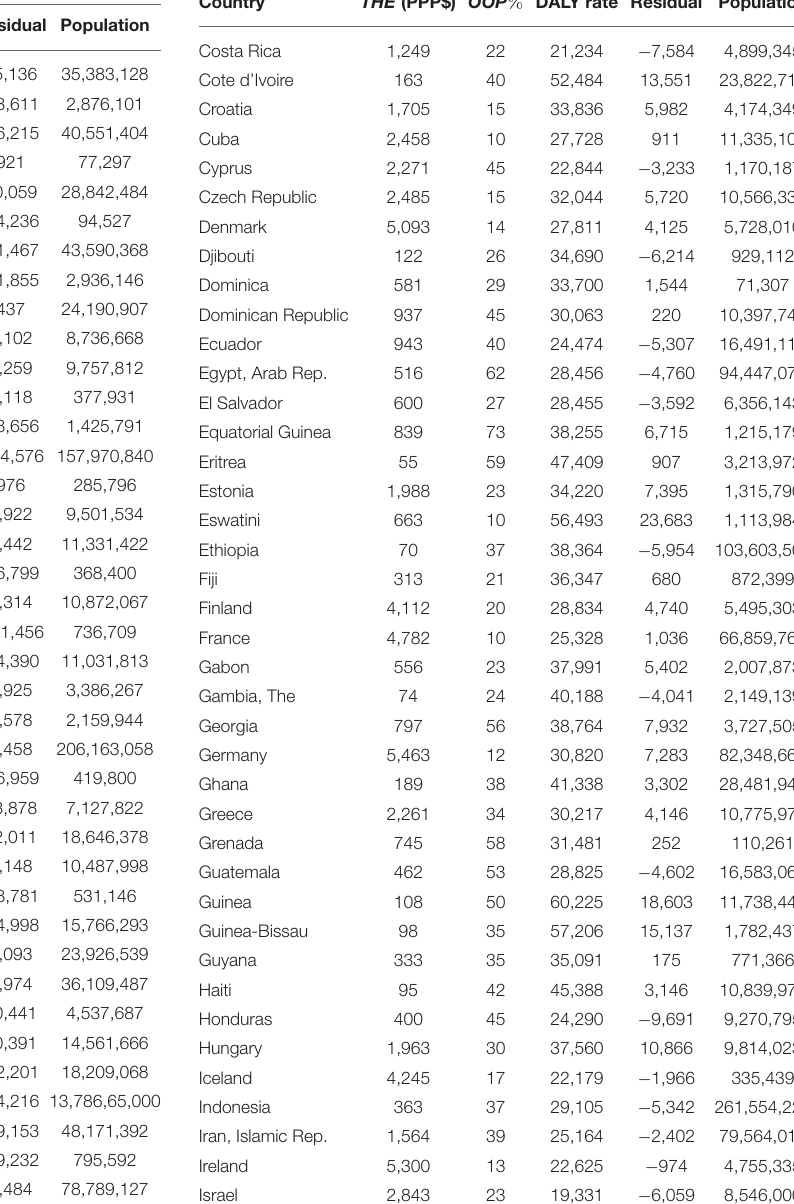
TABLE 12 | Estimated residuals for each country (Costa Rica to Israel).